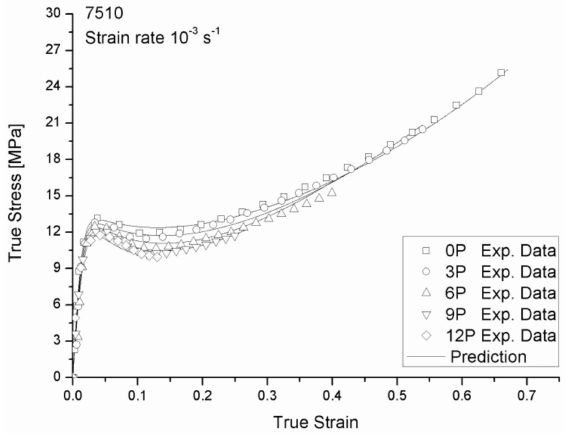
Figure 9. Comparison between the experimental and the predicted tensile behavior of the non-recycled and recycled 7510 under the strain rate of 0.001s − 1